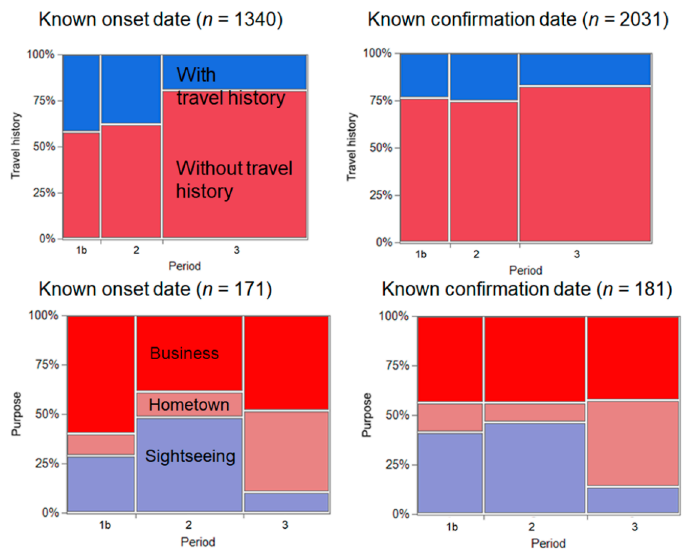
Figure 3. Comparison of coronavirus disease 2019 (COVID-19) incidence before and during the Go To Travel campaign. ( Left ) Cases with known illness onset and ( Right ) cases with known date of confirmation. ( Top ) Comparison by travel history and ( Bottom ) by purpose of travel. Period 1 corresponds to Period 1b (15 July to 19 July). Periods 2 and 3 correspond to 22–26 July and 8–31 August